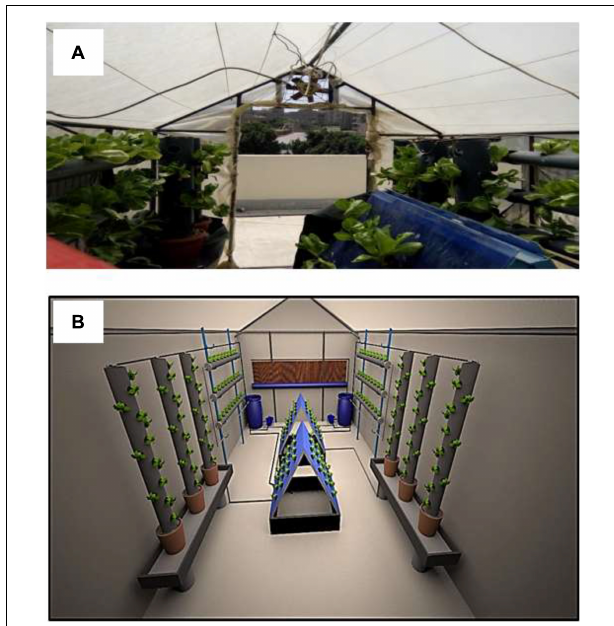
FIGURE 1 | Components of the experimental setup. (A) Photograph. (B) Computer